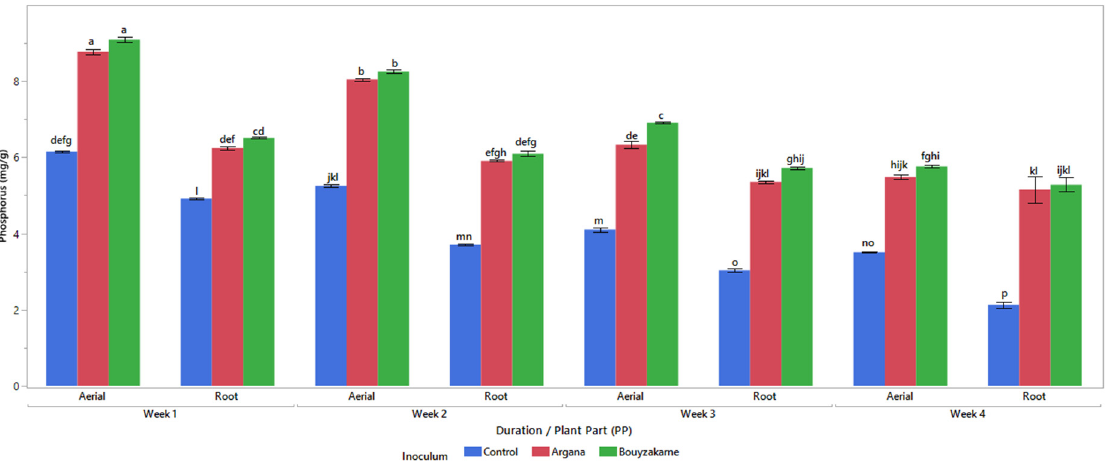
Figure 4. Phosphorus content in the leaves and roots of mycorrhizal and non-mycorrhizal Argan plants subjected to soil water deficit stress for one month (each error bar is constructed using 1 standard error from the mean). Values with different letters are significantly different (Tukey’s test p ≤ 0.05).